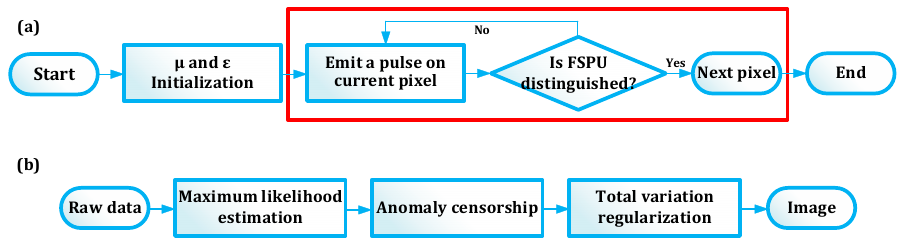
Figure 2. Block diagrams of our FSPU method. ( a ) Block flowchart of acquisition strategy. Processes inside red box would be repeatedly executed until data for all pixels has been obtained. ( b ) Block flowchart of reconstruction strategy.